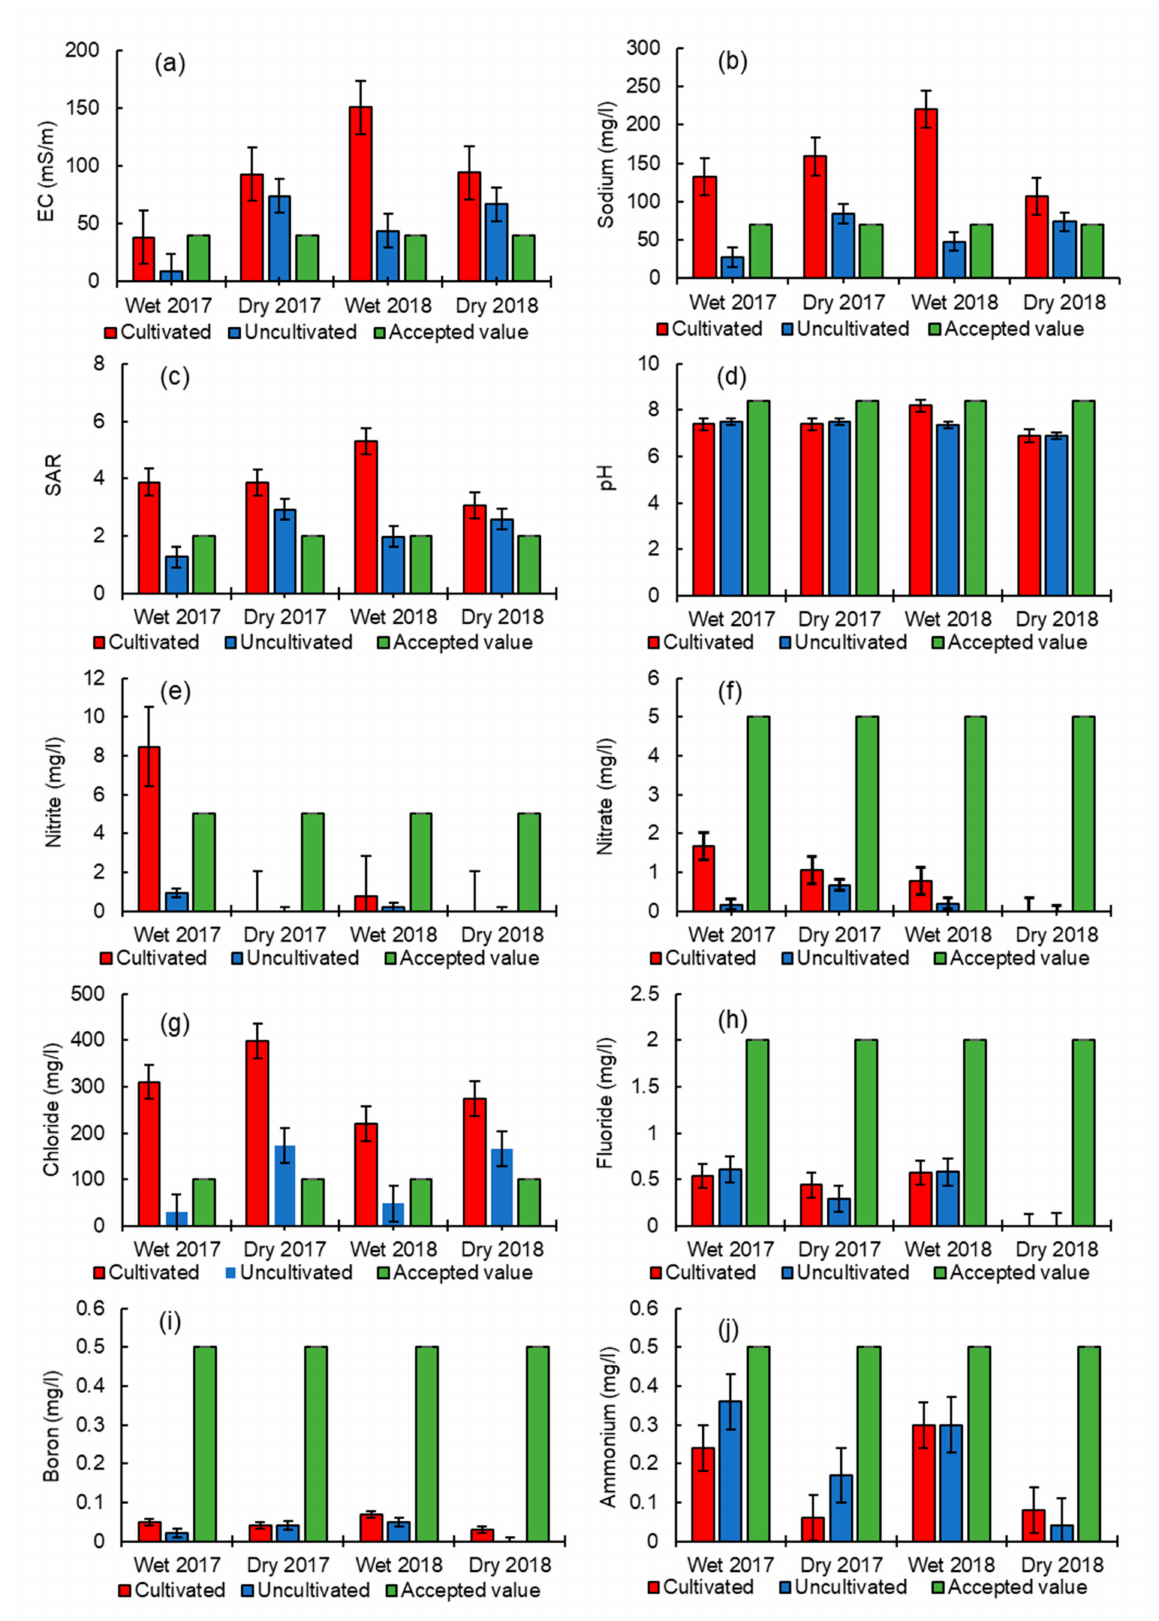
Figure 2. Comparison of water quality constituents recorded in wetlands (uncultivated and cultivated) with South African water quality (SAWQ) target values in wet and dry seasons of 2017 and 2018, ( a ) EC, ( b ) Na, ( c ) SAR, ( d ) pH, ( e ) NO 2 − , ( f ) NO 3 − , ( g ) Cl − , ( h ) F, ( i ) B and ( j ) NH 4+